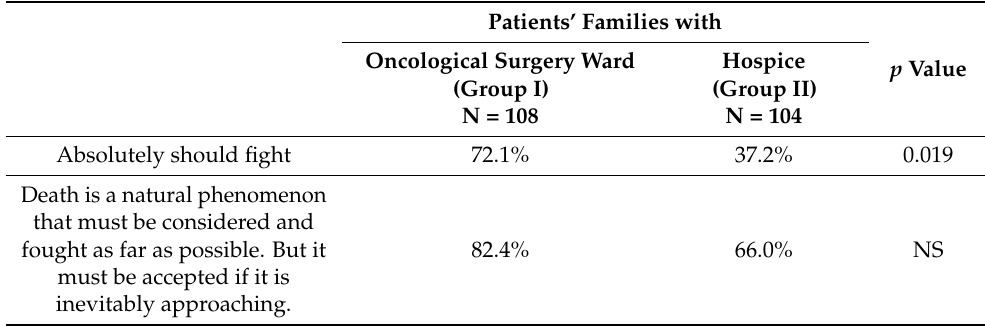
Table 3. The respondent’s opinions about the struggle for the patient’s life in the event of the inevitability of death.